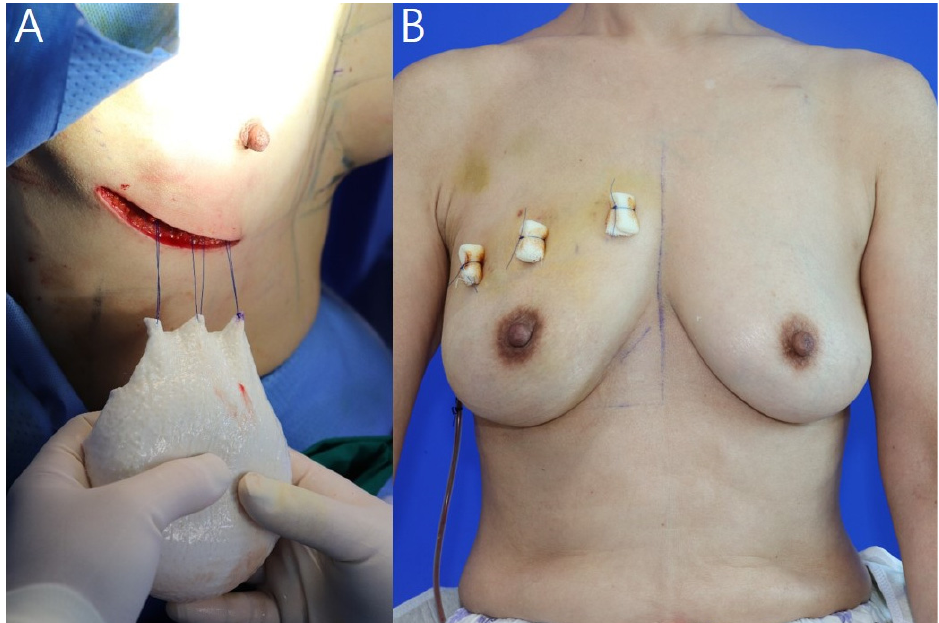
Figure 3. Upper pole pullout suture technique procedures. ( A ) Before inserting the implant, hang it on the ADM upper margin and mastectomy skin upper flap using a Prolene ® 2 ‐ 0 sutures from the outside of the pocket using the pullout suture technique. ( B ) The implant is fixed to the upper pole with a bolster using the pullout suture technique. This 59 ‐ year ‐ old patient was diagnosed with invasive breast cancer of the right breast; the resected breast tissue weighed 219 g. A 150 ‐ cc breast implant and DermACELL ® 16 × 16 cm 2 were placed inside.